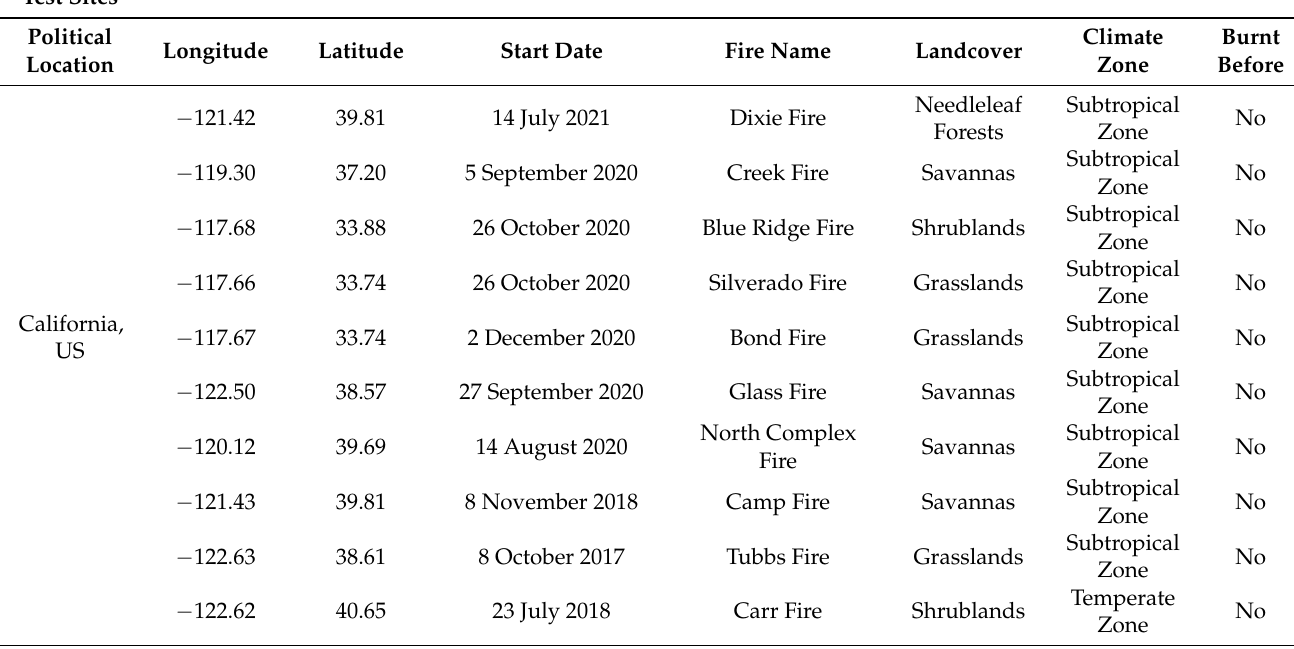
Table 2. Information of Test sites. The duration is not provided as we only focus on the first several days for each wildfire. The name of the wildfire are either named after fire names from The Department of Forestry and Fire Protection of California, fire numbers from British Columbia Wildfire Service, fire numbers from 2020 Major Amazon Fires Tracker, developed by InfoAmazonia, and the location of the wildfire where it